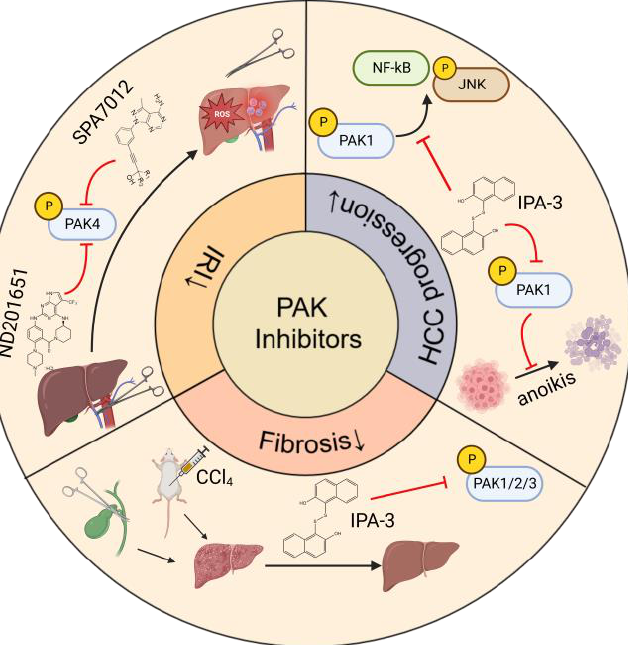
Figure 4. PAK inhibitors applied in liver disorders. Abbreviations: HCC, hepatocellular carcinoma; IRI, ischemia-reperfusion injury; PAK, p21 Activated Kinase; ROS, reactive oxygen species. IPA-3 is a non-ATP-competitive allosteric inhibitor targeting PAK1 phosphorylation.